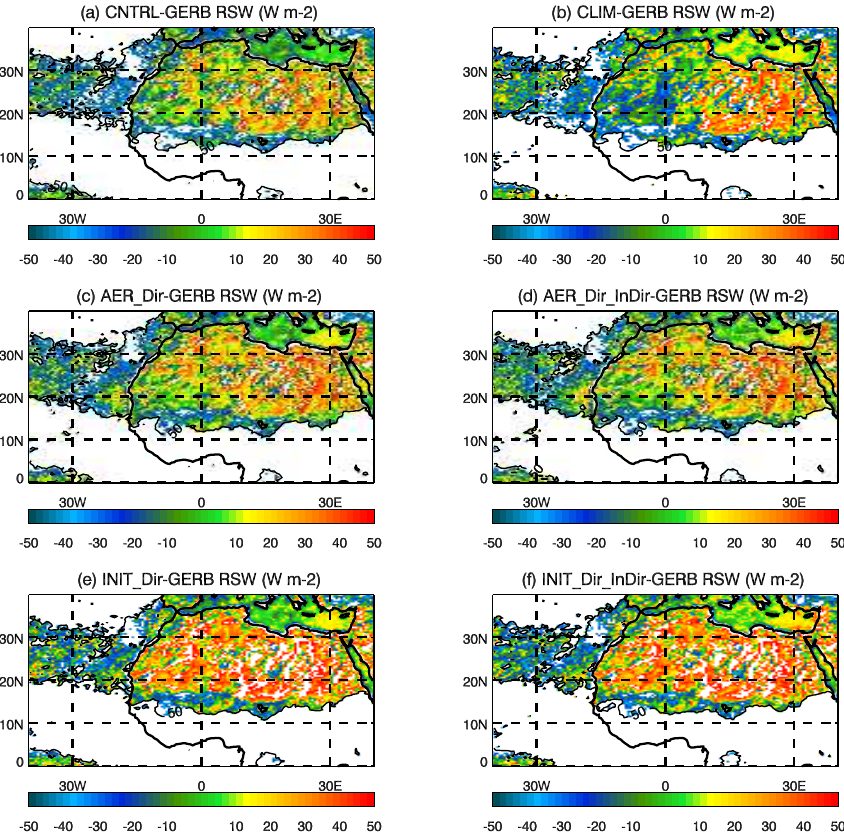
Fig. 7. Reflected short-wave radiation differences at TOA between model and GERB observations from (a) CNTRL, (b) CLIM, (c) AER_DIR, (d) AER_DIR_INDIR, (e) INIT_DIR and (f) INIT_DIR_INDIR. Areas where the cloud fraction exceeds 0.5 have been removed from the